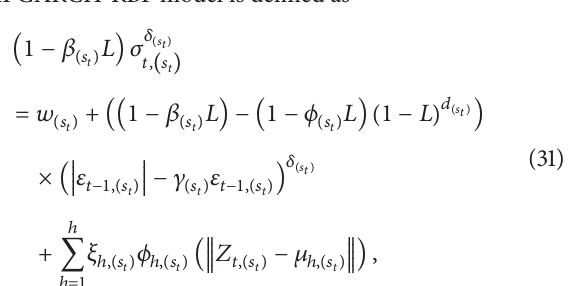
= 2 and 𝛾 = 0 . The model nests MSFINGARCH- (𝑠 𝑡 ) (𝑠 𝑡 ) = 0 , and MSFIGJRGARCH-RBF model RBF model for 𝛾 (𝑠 𝑡 ) = 2 and 𝛾 if 𝛿 (𝑠 (𝑠 𝑡 ) varies between 𝑡 )